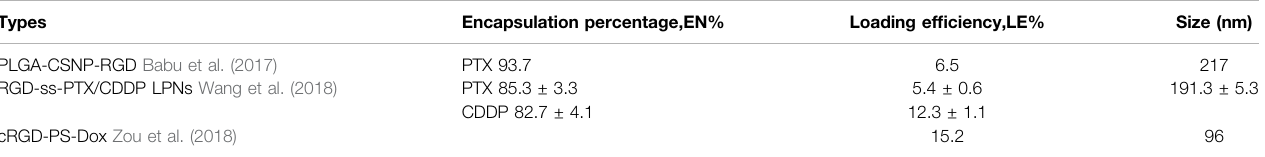
TABLE 4 | av β 3 antibody for active targeting of nanoparticle drug delivery